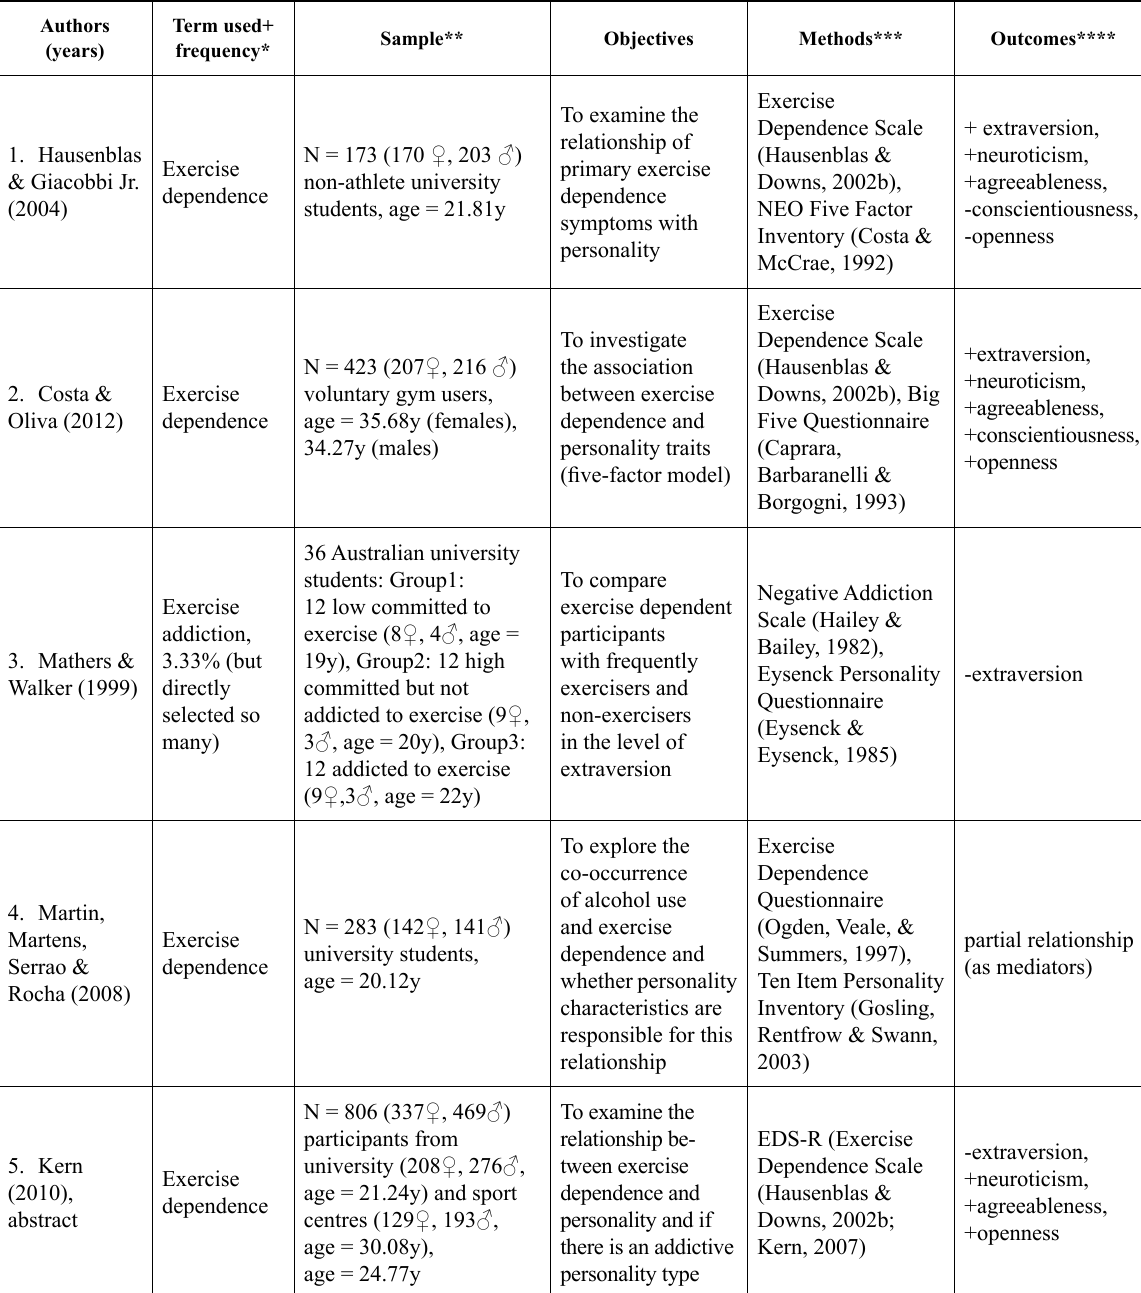
Table 1. Summary of studies between 1995 and 2016 investigating the relationship between exercise addiction and Big Five